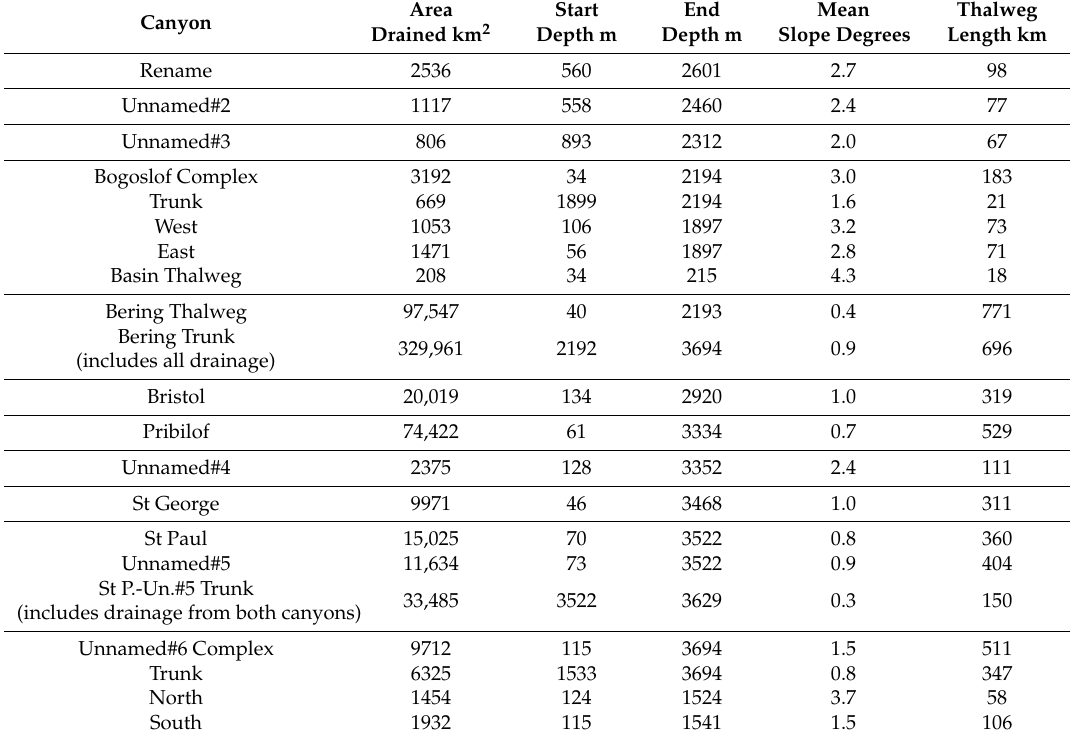
Table 2. Bering Canyon names and metrics described from south to